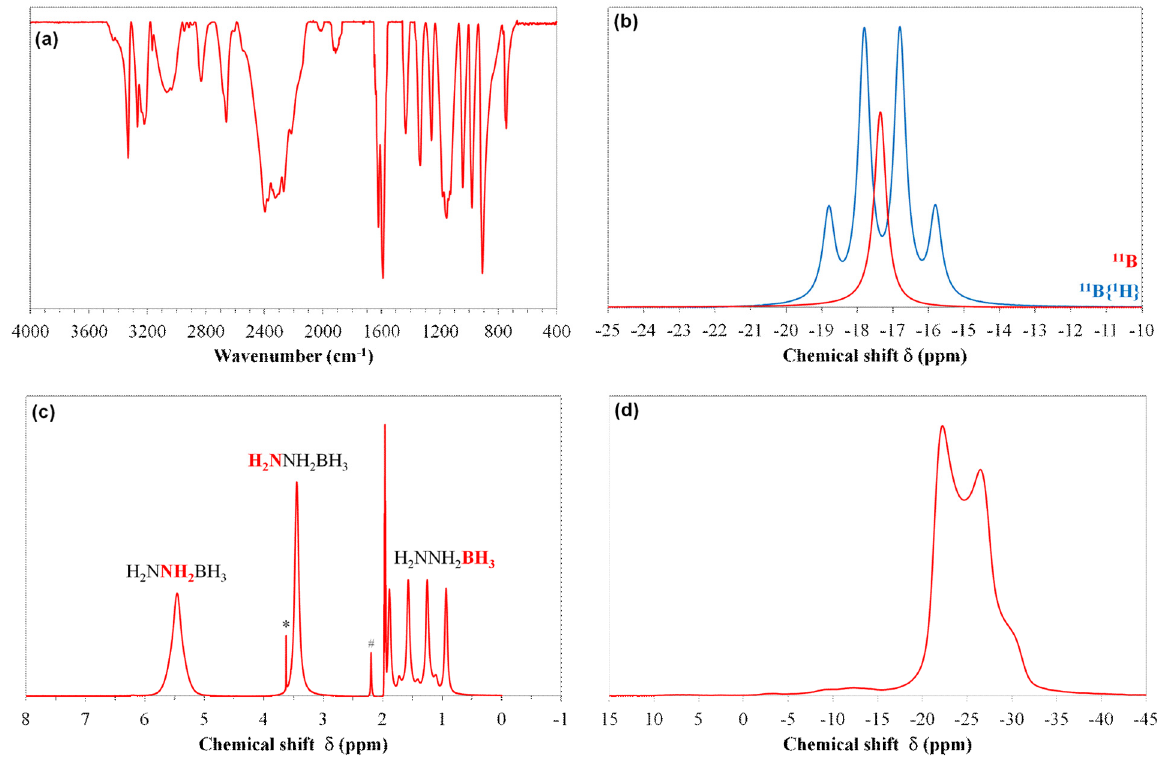
Figure 1. Molecular identification of hydrazine borane N 2 H 4 BH 3 . ( a ) FTIR spectrum; ( b ) solution-state 11 B and 11 B{ 1 H} NMR spectra; ( c ) solution-state 1 H NMR spectrum; and ( d ) solid-state 11 B NMR spectrum. Adapted from [24]—Reproduced by permission of the Physical Chemistry Chemical Physics (PCCP) Owner